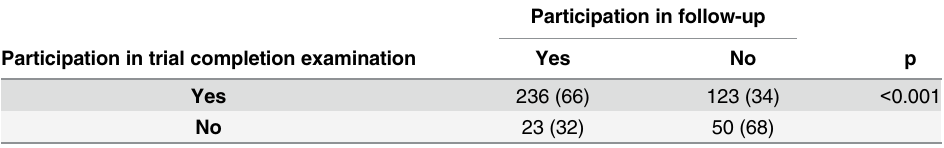
Table 3. Participation in trial completion examination predictive of follow-up participation. Participation in follow-up